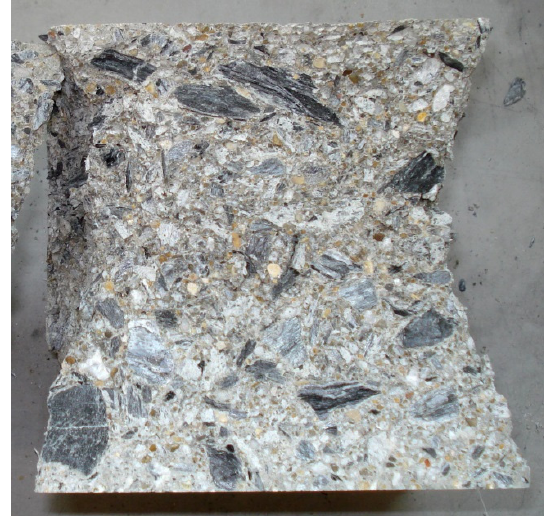
Figure 14. Concrete cube test specimen after compressive strength testing according to Table 7.